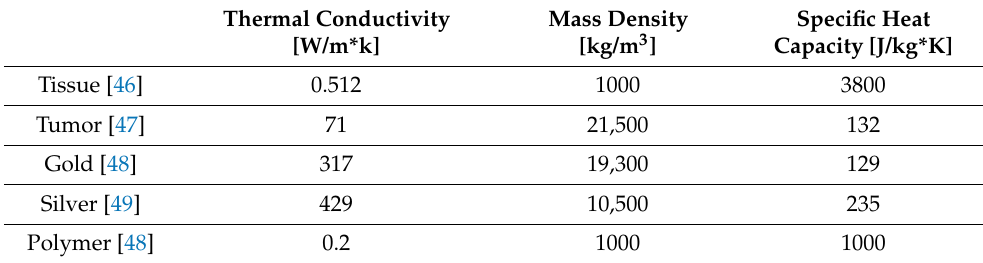
Figure 5. The core–shell structure simulated in COMSOL Multiphysics: ( a ) naked core with radius of 20 nm, with AgNPs with 4 nm radius attached to the core surface, ( b ) core (0 NP) and ( c – e ) 10, 40 and 70 nanoparticles attached to core, ( f ) complete shell (100 NPs). Table 2. Thermal response of source materials used in this work.